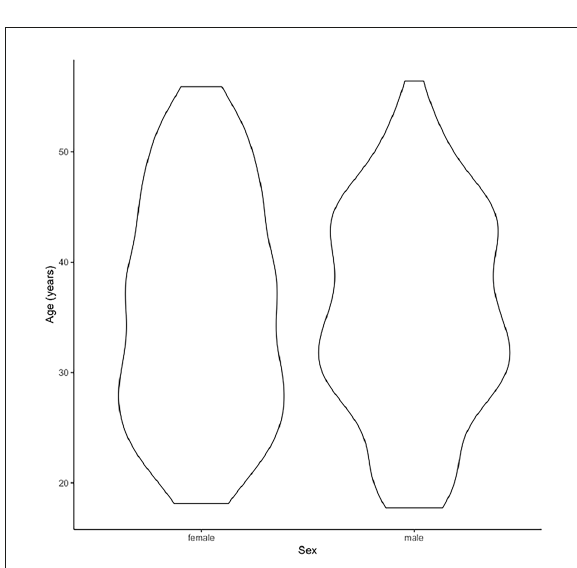
FIGURE2 The figure indicates the age distribution of the magnetic resonance imaging (MRI) cohort of n = 270 healthy controls.